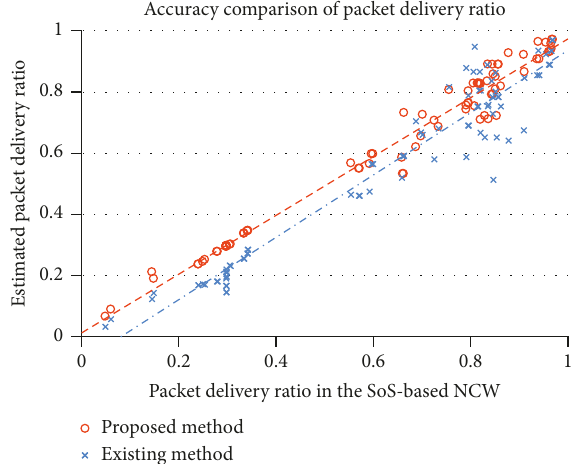
Figure 11: Simulation results for packet delivery ratio comparing between the existing and the proposed methods.